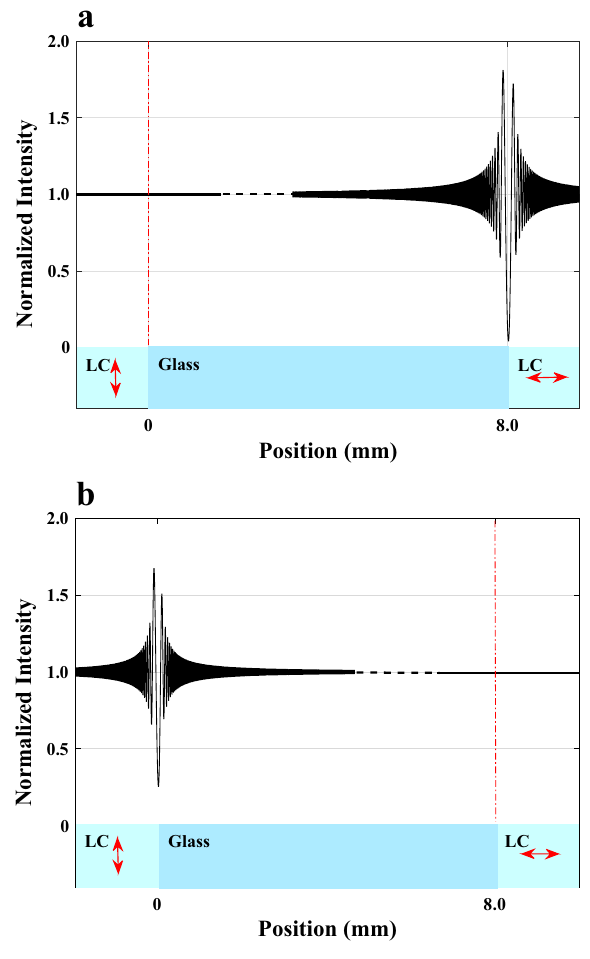
Figure 7. The circumstances under which the visibility of each phase step has a zero value practically correspond to the removal of periodic fringes brought on by diffraction, which causes the light intensity to become uniform. ( a ) There is no diffraction effect when φ o / 2 π = 0 , as the ordinary refractive index of the left LC cell is the same as that of the glass and the transmitted light will not detect any difference between the glass and the LC at a specific temperature. ( b ) The periodic zero condition in the Fresnel-Kirchhoff diffraction formula repeats for values of φ e / 2 π = 1, 2, . . . , causing the normalized phase difference in the right side of the LC cell to provide the precise relationship between the extraordinary refractive index and the glass as given by Eq.